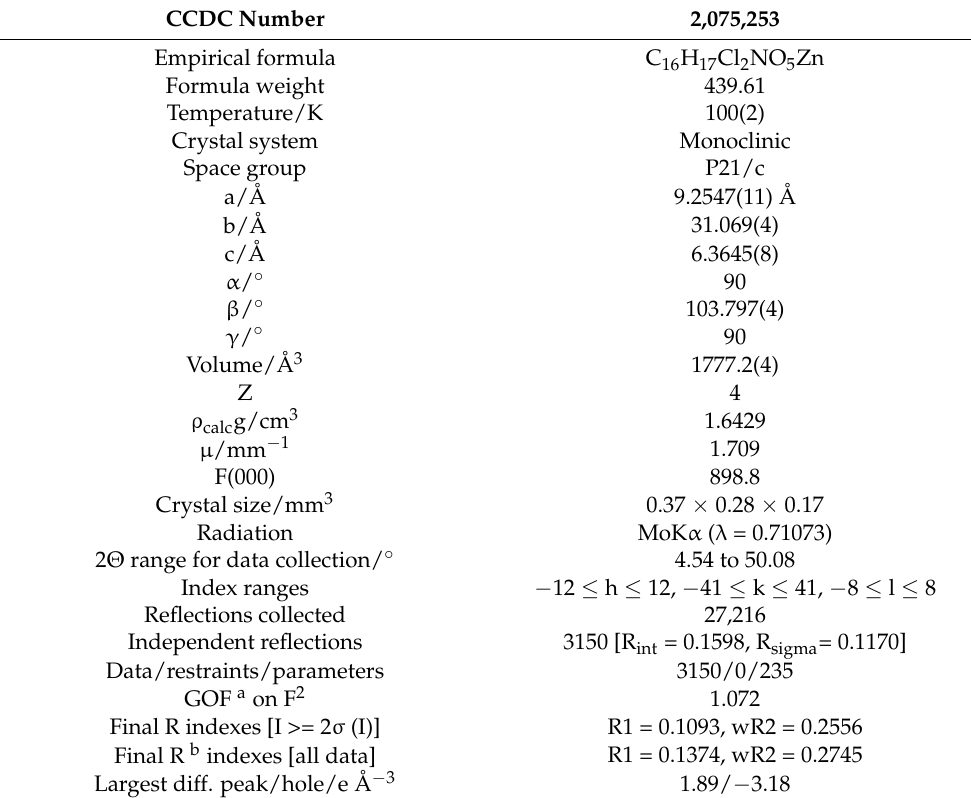
(Table 2) extends it to the 3D supramolecular structure. Table 1. Crystal and structure refinement data for complex 1 .